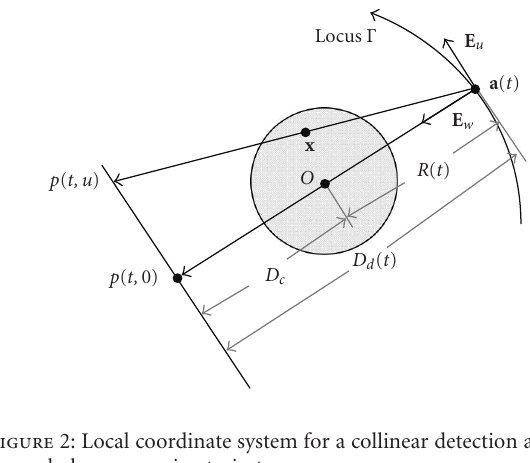
Figure 2: Local coordinate system for a collinear detection along a general planar scanning